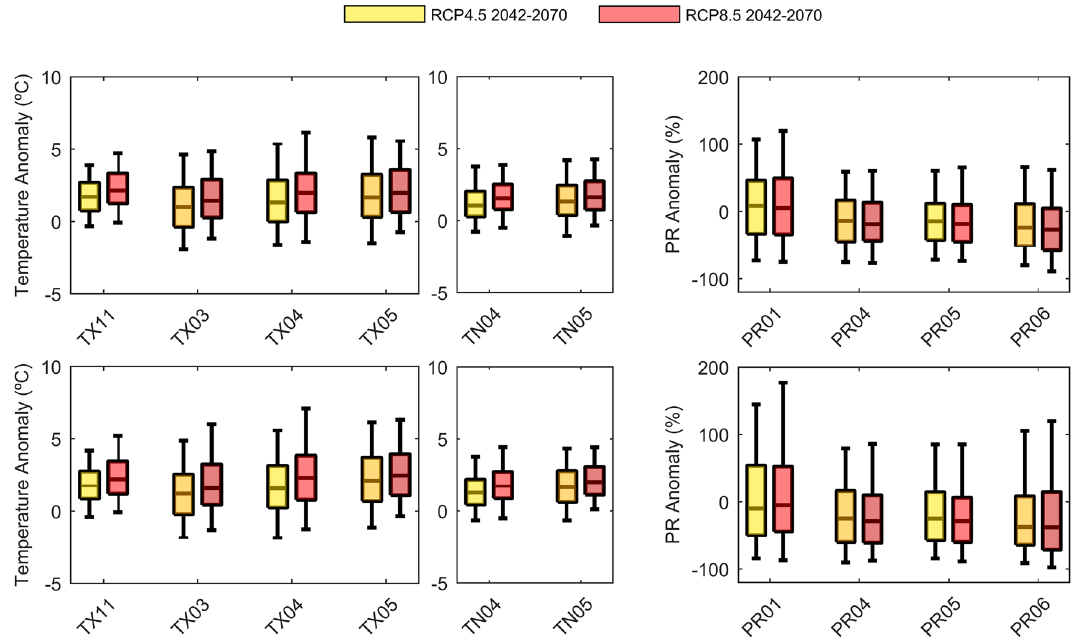
Figure 6. Distribution of TX (°C), TN (°C) and PR (%) anomalies (future–historical) for the most relevant predictors (TX11, TX03, TX04 and TX05; TN04 and TN05; PR01, PR04, PR05 and PR06) for cluster 1 (top) and cluster 2 (bottom). Each boxplot represents the combined distribution of the CORDEX available models for the: (yellow) RCP4.5 2042–2070; (orange) RCP8.5